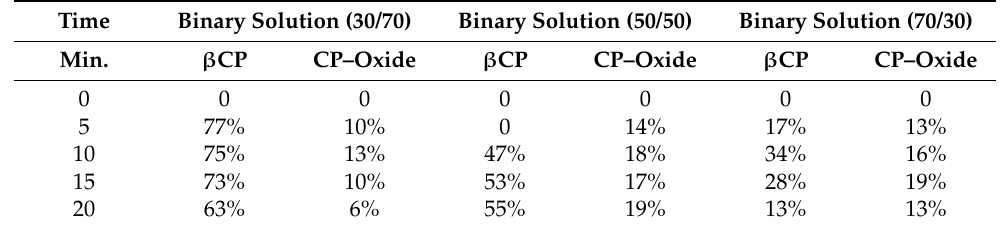
Table 2. Extraction of β CP and CP–oxide from binary solutions of ratios 30/70, 50/50, and 70/30.